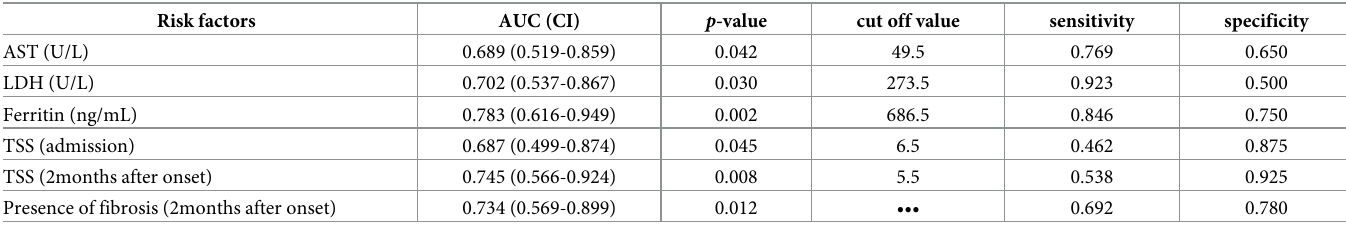
Table 3. ROC curve and cut-off value for each risk factor.